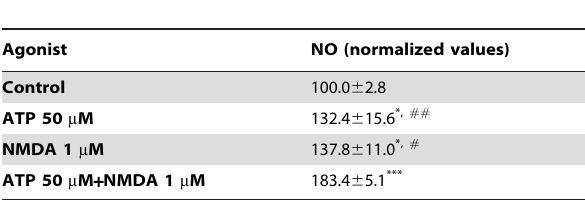
Table 2. NO production in cultured rat hippocampal neurons. Agonist NO (normalized values)